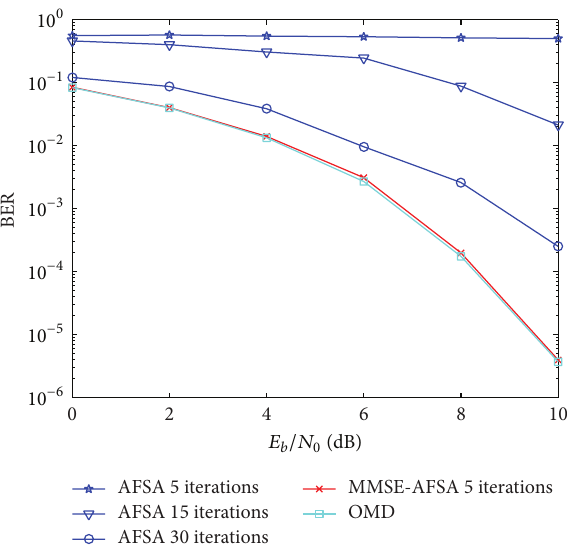
Figure 6: Convergence rate of AFSA detector and MMSE-AFSA